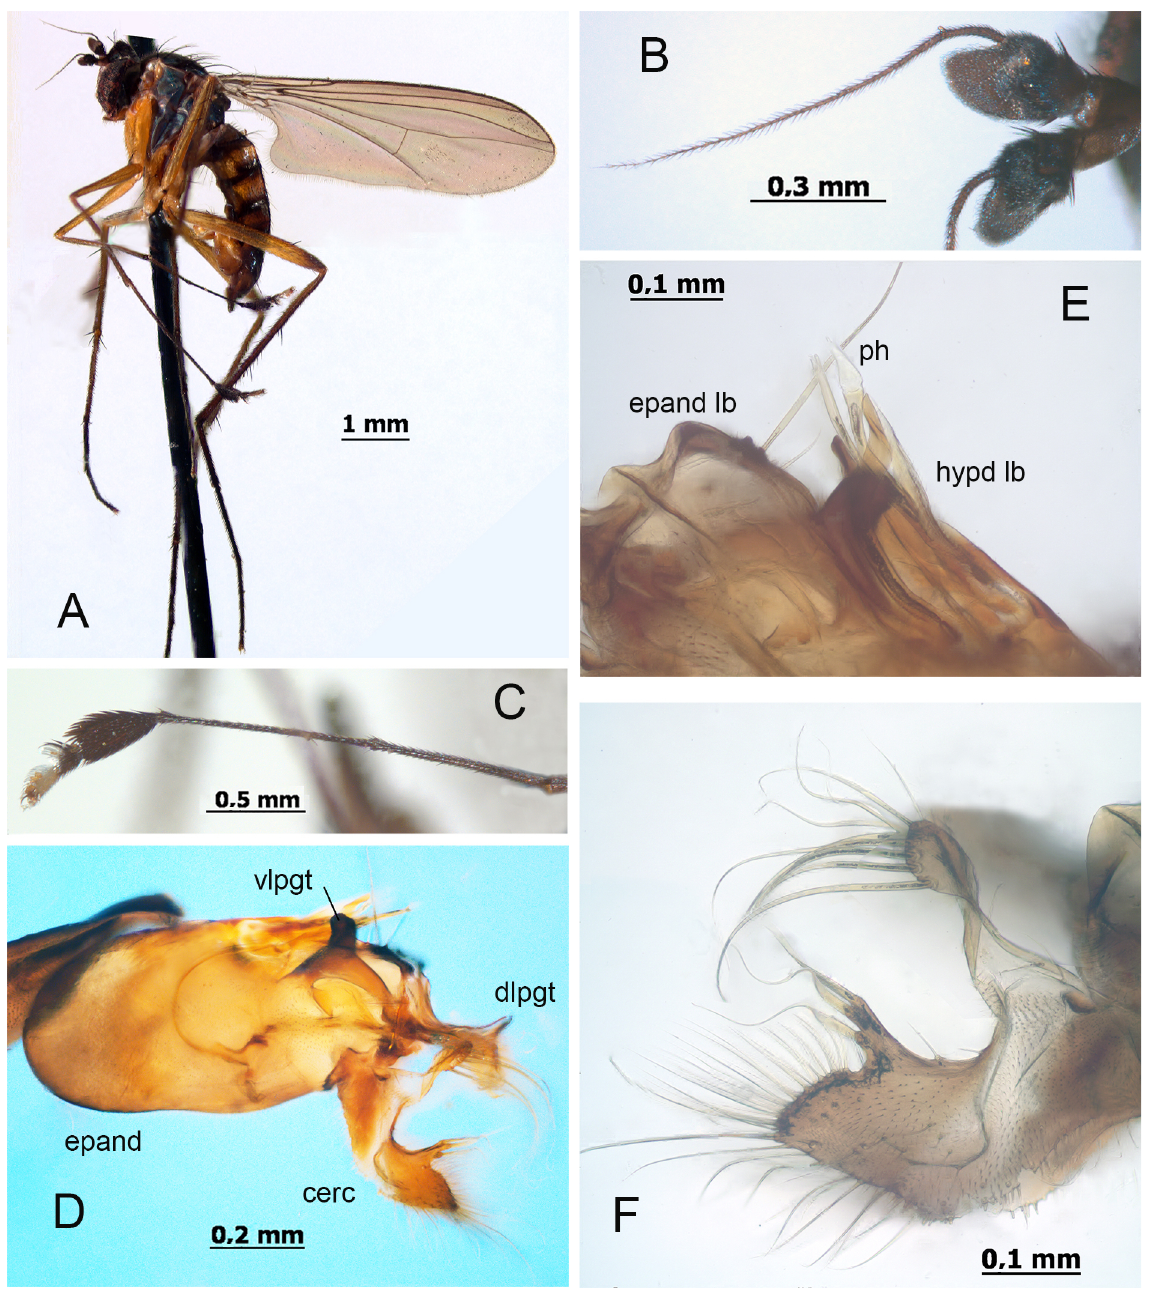
Fig. 5. Hercostomus vikhrevi sp. nov., ♂, holotype (ZMUM). A . Habitus. B . Antenna. C . Fore tarsus. D . Hypopygium, right lateral view. E . Distoventral appendages of epandrium. F .